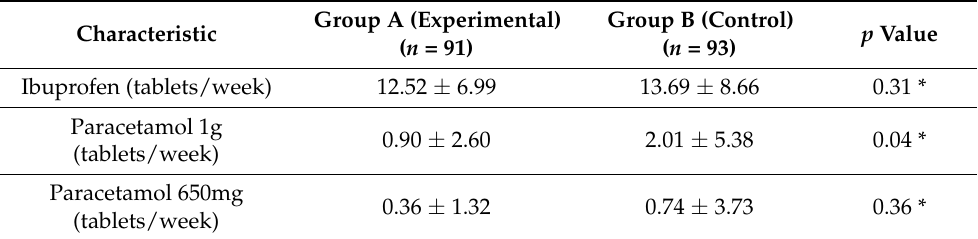
Table 4. Comparison of the number of tablets of analgesics depending on the type of anaesthetic technique in two groups, A (experimental) and B (control). Group A (Experimental) Group B (Control) p Value Characteristic ( n = 91) ( n = 93) Ibuprofen (tablets/week) 12.52 ± 6.99 13.69 ± 8.66 Paracetamol 1g 0.90 ± 2.60 (tablets/week) Paracetamol 650mg